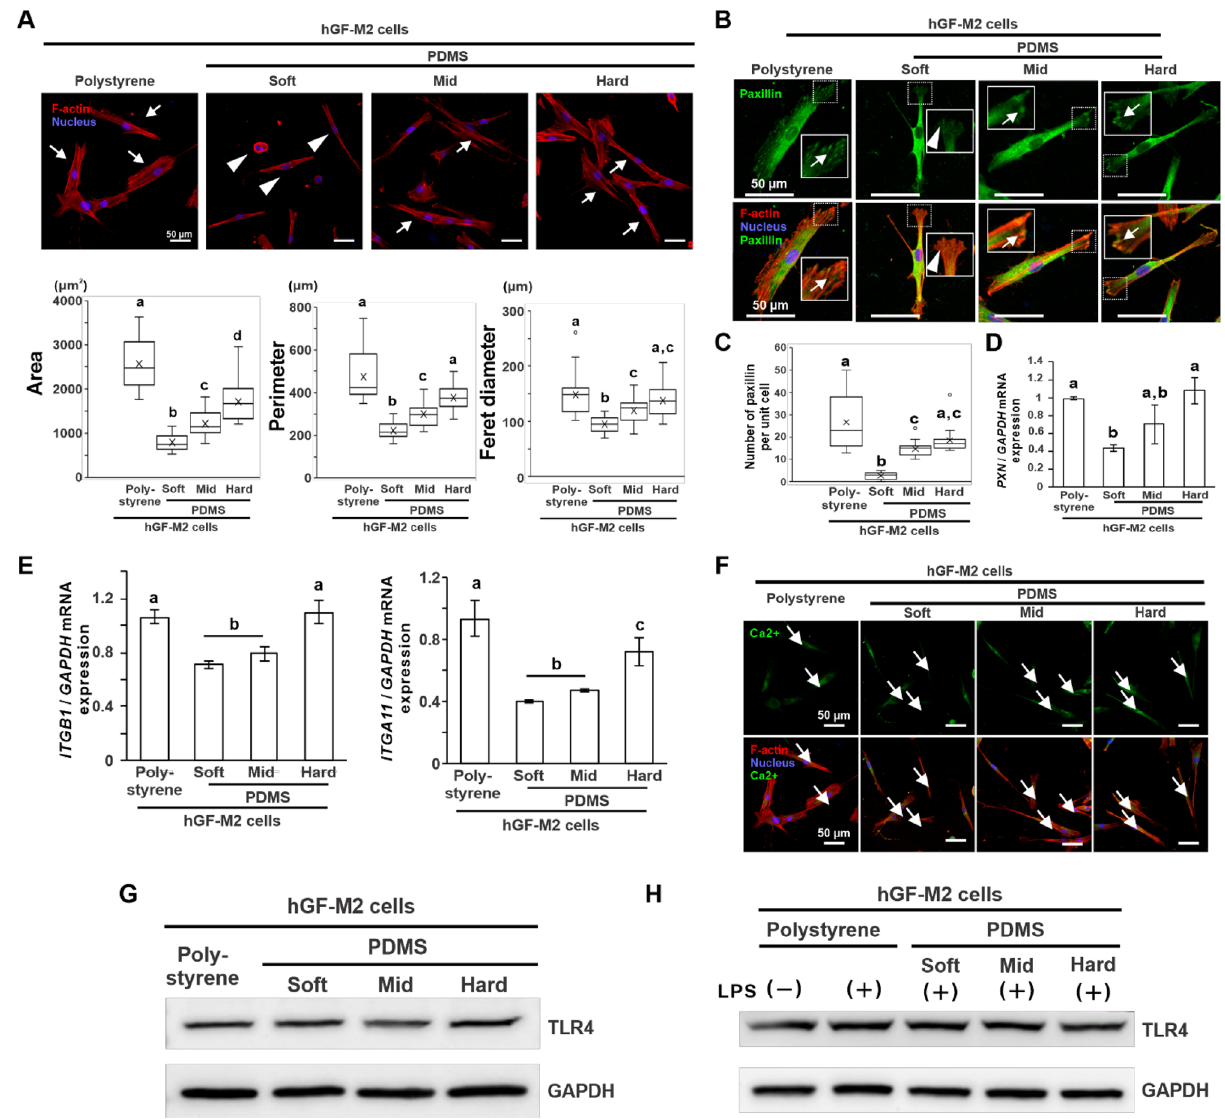
Figure 6. Effects of substrate stiffness on the cell morphology and focal adhesion in hGFs. ( A ) Representative confocal laser microscopic images of F -actin (red) and nucleus (blue) and the corresponding cytomorphometry parameters regarding area, perimeter, and Feret diameter in hGF-M2 cells cultured on the 0.1wt% collagen- coated polystyrene culture plate and soft, mid, and hard PDMS for 12 h. Immunofluorescence confocal laser microscopic images of paxillin ( B ) or intracellular calcium ions ( F ) (green), F -actin cytoskeleton (red), and nucleus (blue), ( C ) the number of paxillin per unit cell analyzed on the corresponding immunofluorescence confocal microscopy images, and Reverse transcription-polymerase chain reaction (RT-PCR)-based gene expression analysis of PXN ( D ), ITGB1 and ITGA11 ( E ) relative to GAPDH in hGF-M2 cells cultured on the 0.1wt% collagen-coated polystyrene culture plate and soft, mid, and hard PDMS for 12 h. Data are represented as the means ± standard deviation (SD; N = 15 in A and C , N = 3 in D and E ). ( G , H ) Western blotting analysis of the TLR4 and GAPDH protein expression in hGF-M2 cells cultured on the 0.1wt% collagen-coated polystyrene culture plate and soft, mid, and hard PDMS without and with co-incubation with 1,000 ng/mL of LPS for 12 h. Different letters indicate the statistically significant difference between them ( P < 0.05; Dann-Bonferroni test in ( A ) and ( C ), Tukey’s honestly significant difference [HSD] test in D , E ). Squared images in ( B ) indicate the expanded images corresponding to the area surrounded by dashed squares. Note: ( A ) Small or rounded shapes with less cytoskeletal development on the soft PDMS (triangles) in contrast with well-spread spindle shapes with cytoskeletal development on the other substrates (arrows), ( B ) less paxillin signals on the tips of cellular projections (triangles) of hGF-M2 cells on soft PDMS in contrast with many signals (arrows) in the cells on the polystyrene and the other PDMS substrates, and ( F ) the green signals (arrows) are visible in hGF-M2 cells on all types of substrates. hGFs human gingival fibroblasts, PDMS polydimethylsiloxane, ECM extracellular matrix, PXN paxillin, ITGB1 Integrin β 1, ITGA11 Integrin α 11, Ca 2+ calcium ions, LPS lipopolysaccharide, TLR4 toll- like receptor 4, GAPDH glyceraldehyde-3-phosphate